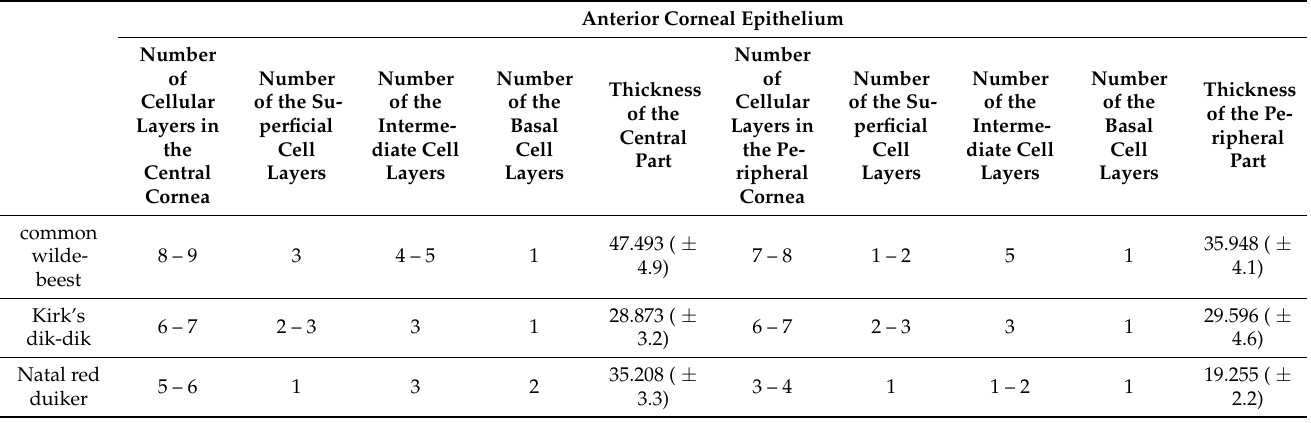
Figure 1. The photomicrograph of the cornea in the examined ruminants. H&E stain. ( a )—common wildebeest, ( b )—Kirk’s dik ‐ dik, ( c )—Natal red duiker, ( d )—scimitar oryx, ( e )—sitatunga, ( f )—Phil ‐ ippine spotted deer, ( g )—Père David’s deer, ( h )—moose, ( i )—reindeer, ( j )—reticulated giraffe, ( k )— okapi, ( l )—Balabac mouse ‐ deer, ( m )—alpaca. Scale bar: ( a , k ) = 20 μ m; ( b – j , l – m ) = 10 μ m. ace—an ‐ terior corneal epithelium, alm—anterior limiting membrane (Bowman layer—blue arrow), ker— keratocytes (black arrow), psc—the proper substance of the cornea. Table 2. Morphometrical features of the anterior corneal epithelium in the examined ruminants. Anterior Corneal Epithelium